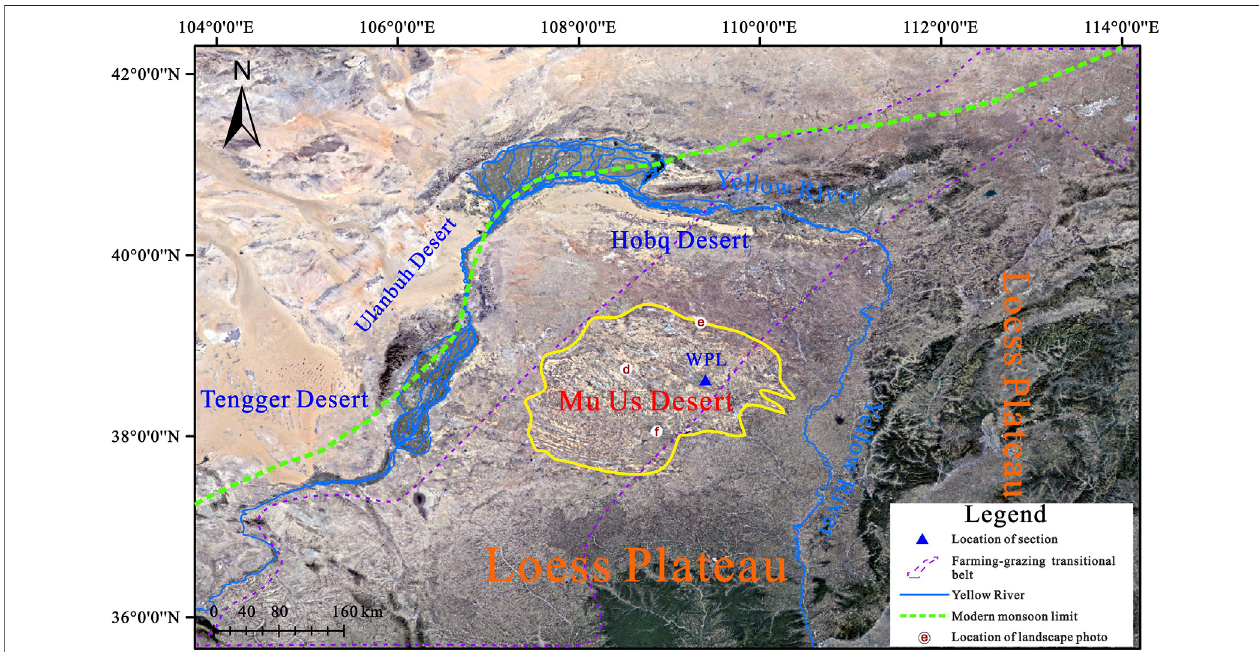
FIGURE 1 | The geographical location of the Mu Us Desert, China. The locations of landscape photo d, e, and f correspond to the picture of Figures 4D – F , respectively.